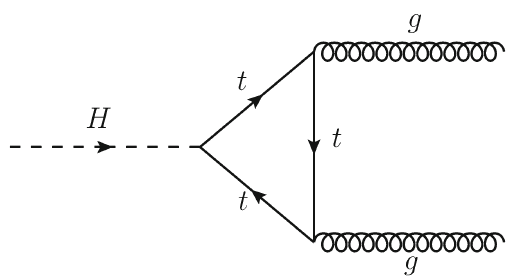
Fig. 2 The Feynman diagram of the Higgs boson decay to gluon pair through the virtual top quark loop